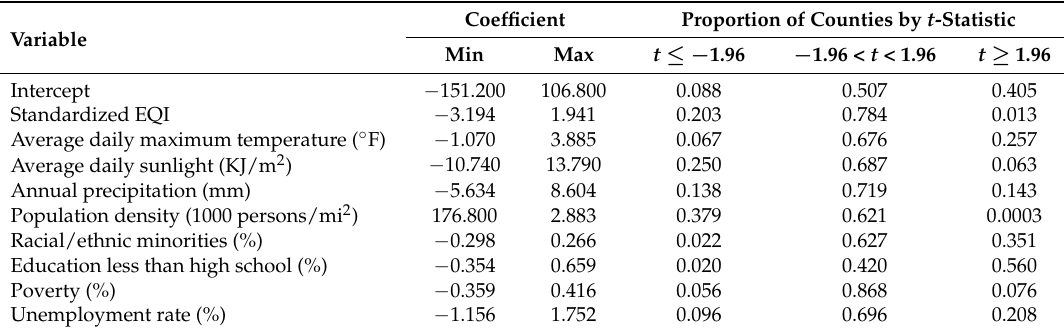
Table 4. Estimated effect of overall environmental quality index (EQI) on county-level prevalence of physical inactivity using geographically weighted regression (GWR).